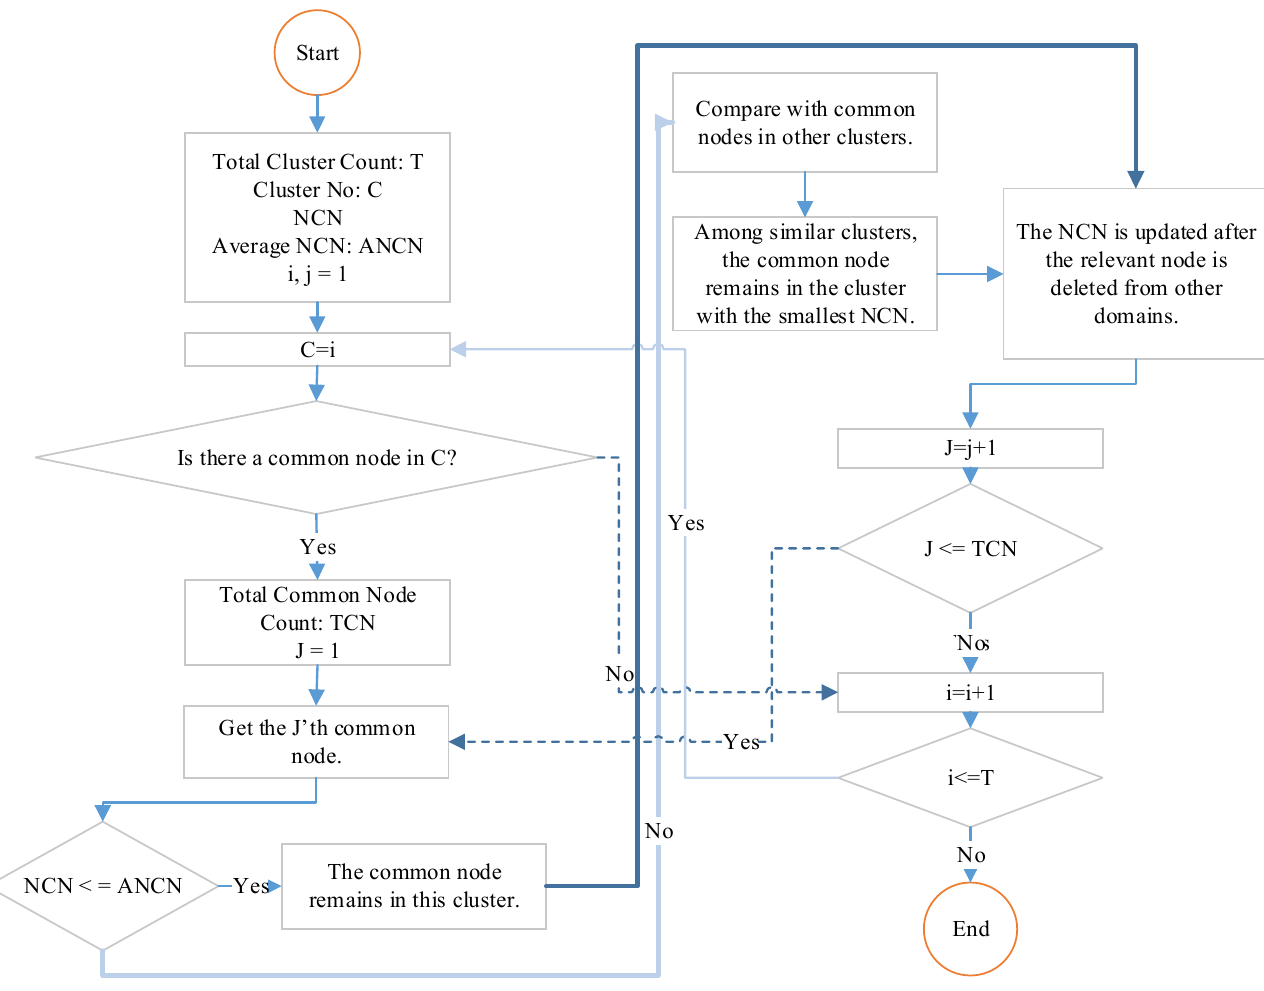
Figure 10. Flowchart determining actual clusters of common nodes.